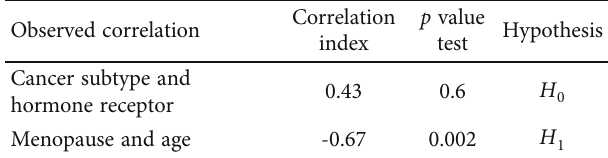
Table 9: Tests of hypothesis TCGA